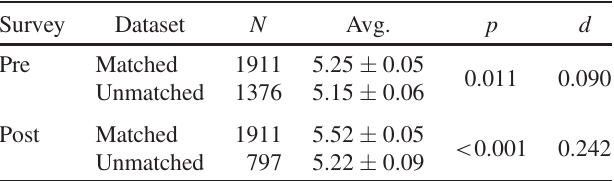
TABLE X. Scores from respondents who took both a closed- response pre- and post-survey (matched dataset) and students who only took one closed-response survey (unmatched dataset). p values and effect sizes d are reported for the differences between the matched and unmatched datasets in each